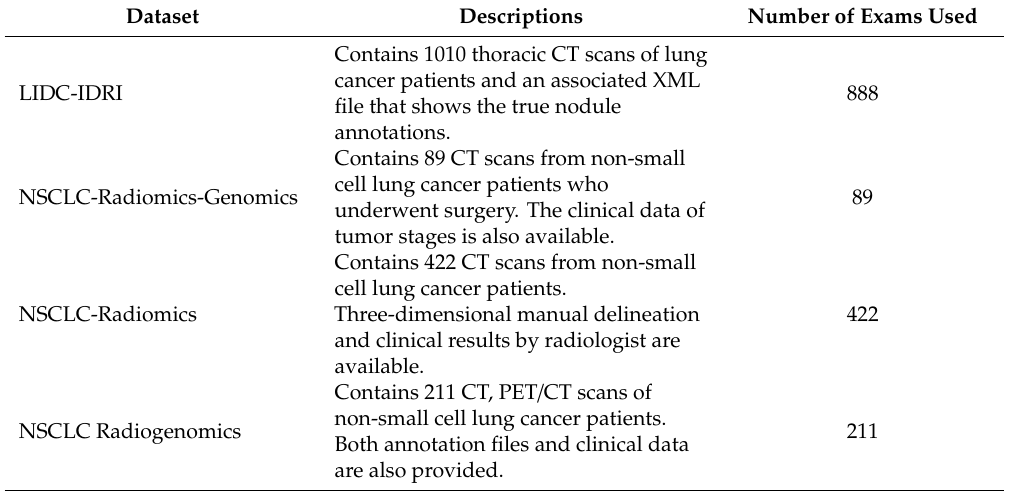
Table 4. Detailed descriptions of the datasets applied.